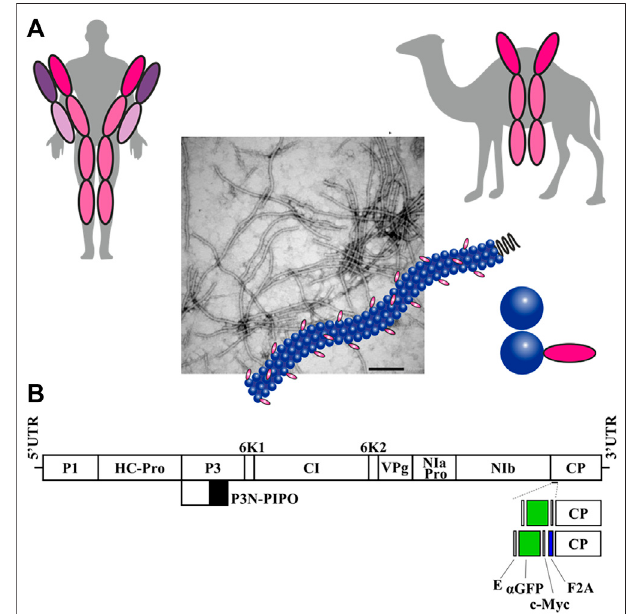
FIGURE 1 | Production of potyvirus nanoparticles decorated with a nanobody in biofactory plants. (A) Schematic comparison of a conventional human antibody and a camelid heavy-chain antibody, from which single- domain antibodies or nanobodies are derived. A potyvirus virion partially decorated with nanobodies in its surface is also schematized. (B) Schematic representation of the ZYMV genome indicating the position where a heterologoussequencecodingforananti-GFPnanobody( α GFP) fl ankedwith E and c-Myc epitopes was inserted, along with picornavirus F2A peptide. LinesrepresentZYMV5 ′ and3 ′ UTRs;boxesrepresentP1,HC-Pro,P3,P3N- PIPO, 6K1, CI, 6K2, VPg, NIaPro, NIb, and CP cistrons, as indicated. Scale bar corresponds to 1000